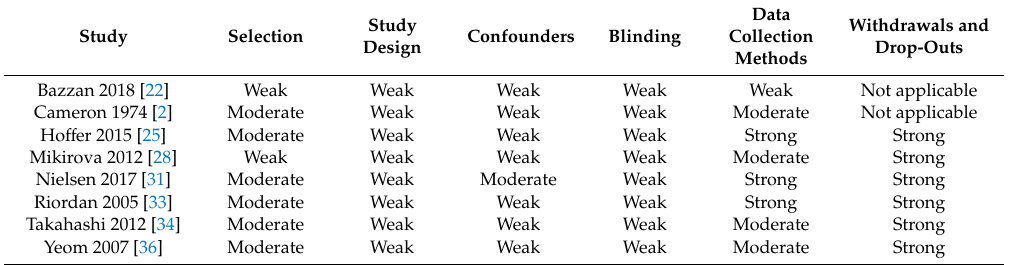
Table 3. Quality assessment of non-comparative studies. Judgment for quality of the studies based on the Effective Public Health Practice Project tool for each included non-comparative study (strong, moderate, weak).